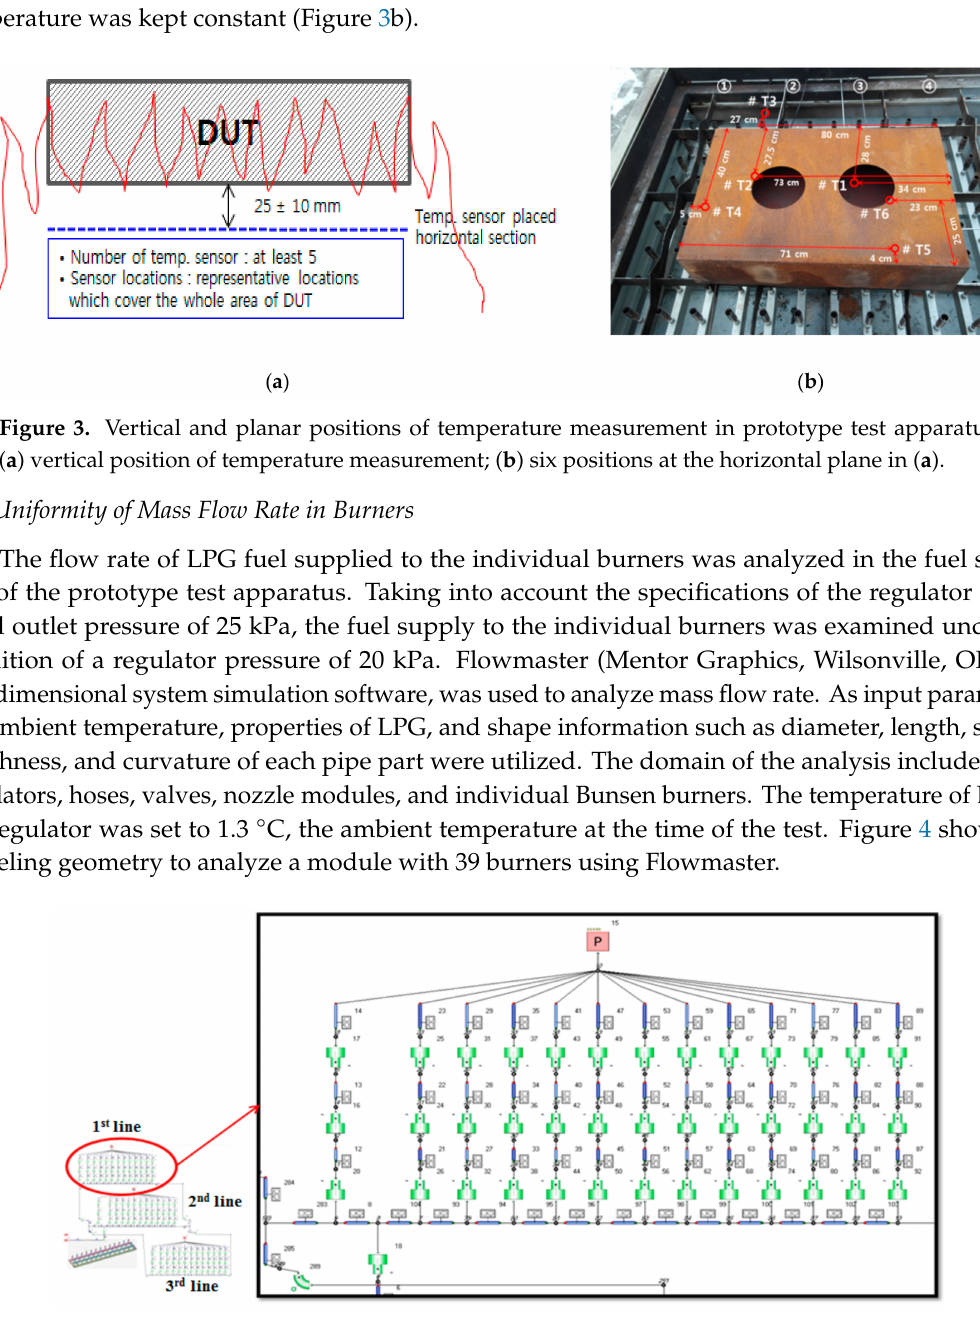
Figure 4. Modeling geometry of fuel supply system for one module consisting of 39